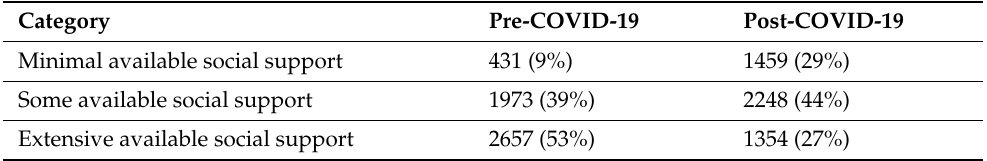
Table 2. Perceived social support immediately prior to COVID-19 and at the time of the survey.